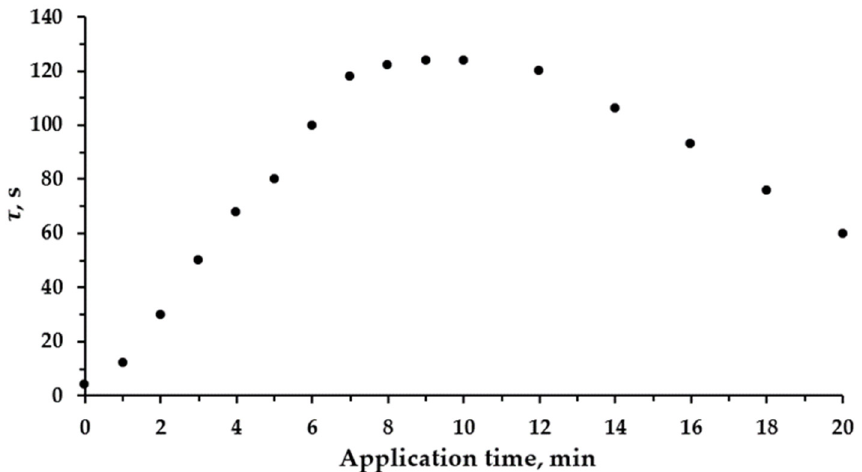
Figure 7. Time of the protective action of coatings formed after etching AMg6 alloy in 10 wt% aqueous solution of sodium hydroxide followed by hydrophobization with a stearic acid solution (3 g·L − 1 ) in a DMSO/H 2 O binary mixture (7:1 v / v ) at 40 °C for various modification times.